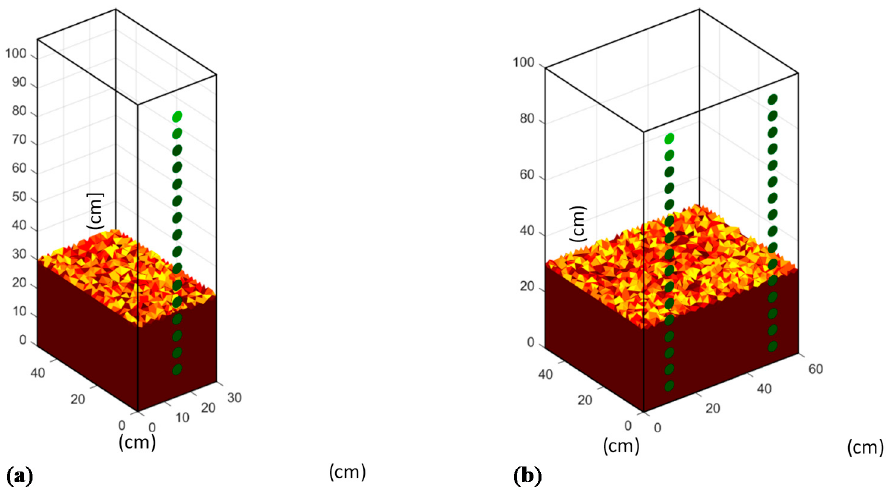
Figure 6. Conductivity distributions defined for the purpose of creating simulation data frames on the very dense finite element mesh: (a) for 16 electrodes, (b) for 32 electrodes.